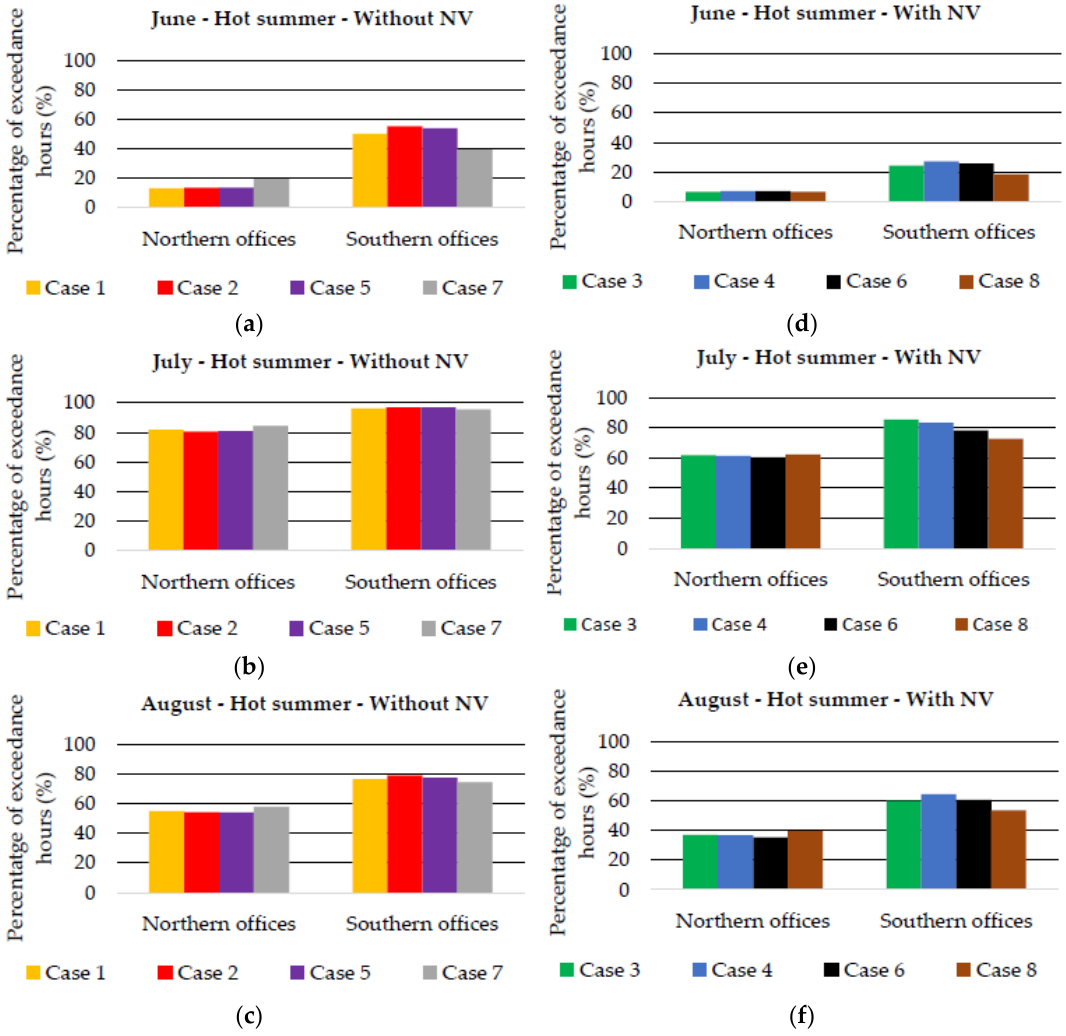
Figure 8. Percentage of exceedance hours in offices during the hot summer of 2018 ( a – c ) without NV and ( d – f ) with NV. Cases 1 and 3: All doors always closed, Cases 2 and 4: Northern offices’ doors always closed/Southern offices’ doors open during working hours, Cases 5 and 6: Northern offices’ doors always closed/Southern offices’ doors always open, Cases 7 and 8: All doors always open. Southern offices represent offices with southeast orientation with higher internal solar gains compared to other offices. Northern offices represent all other offices excluding the open-plan office.